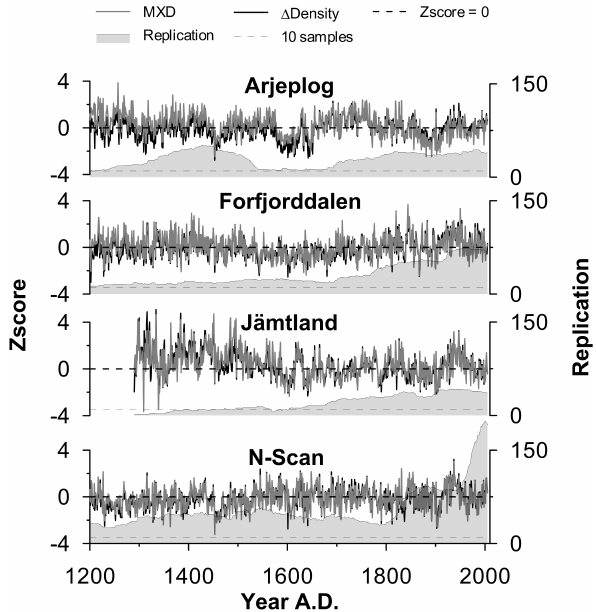
Fig. 7. Raw MXD chronologies in grey plotted together with raw Figure 7. Raw MXD chronologies in grey plotted together with raw Δ Density chronologies in 2 1 density chronologies in black. The three reference chronologies black. The three reference chronologies Jämtland, Forfjorddalen and N-Scan have very 3 Jämtland, Forfjorddalen and N-Scan have very similar MXD and similar MXD and Δ Density counterparts. Note that the Arjeplog MXD and Δ Density 4 1 density counterparts. Note that the Arjeplog MXD and 1 density chronologies have visible differences in trends. Grey-shaded areas chronologies have visible differences in trends. Grey shaded areas indicate sample depth 5 indicate sample depth through time, and light-grey-dotted lines in- through time, and light grey dotted lines indicate ten samples. 6 dicate 10